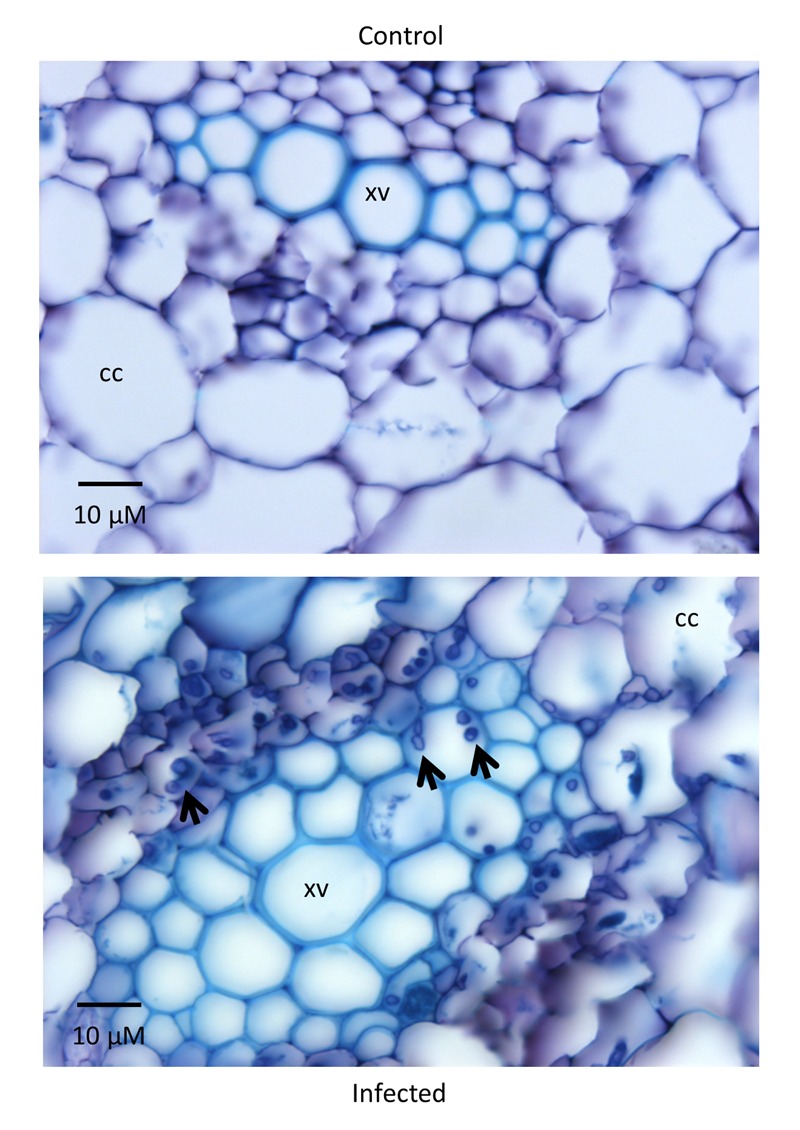
Root sections of Lutea plants 22 DPI. The control plant (inoculated with water) on the top shows no signs of infection while the treated plant (isolate #81 inoculum) on the bottom has hyphae (indicated by arrowheads) colonizing the cortical cells (CC) and the xylem vessels (XV). Sections of 12 μm were stained with toluidine blue.